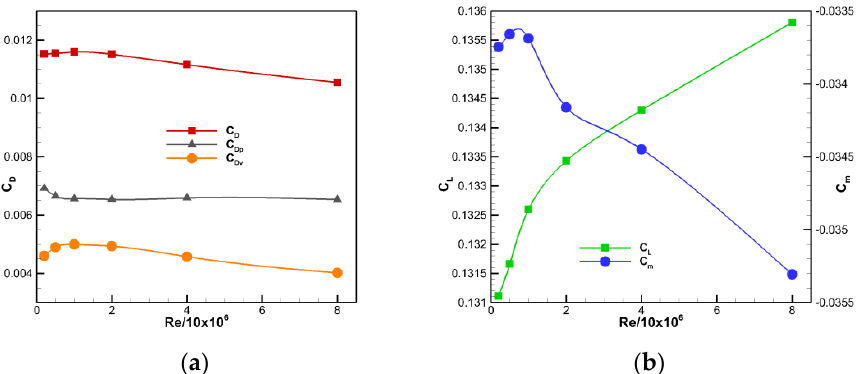
Figure 6. Effects of the Reynolds number on aerodynamics ( T u = 0.1%, M = 0.9, α = 2°). ( a ) Drag coefficients vs. Reynolds number; ( b ) lift and pitch moment coefficients vs. Reynolds number.